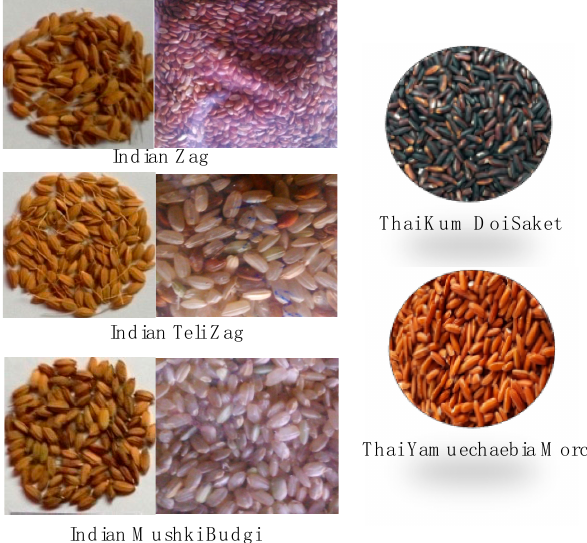
Figure 1. Examples of local Indian and Thai pigmented rice verities ( Oryza sativa ).